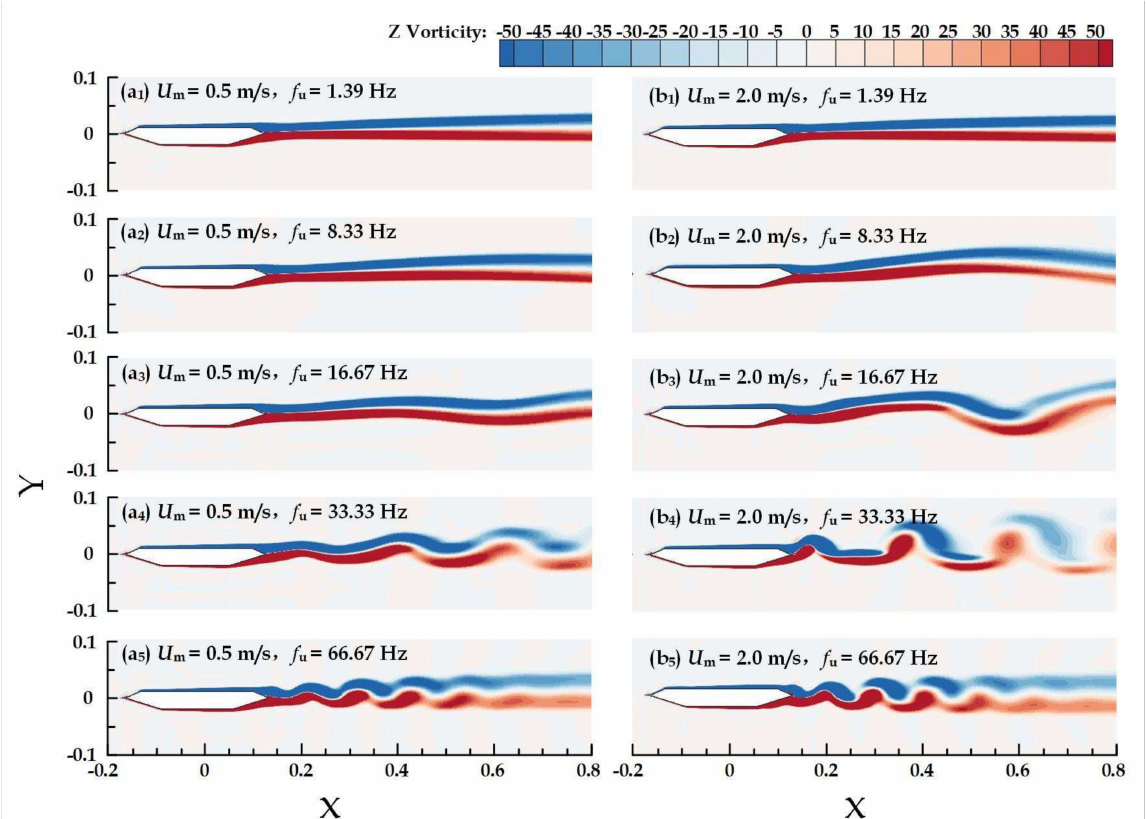
Figure 15. Vortex shedding in sinusoidal oscillating flows: ( a 1 ) U m = 0.5 m/s, f u = 1.39